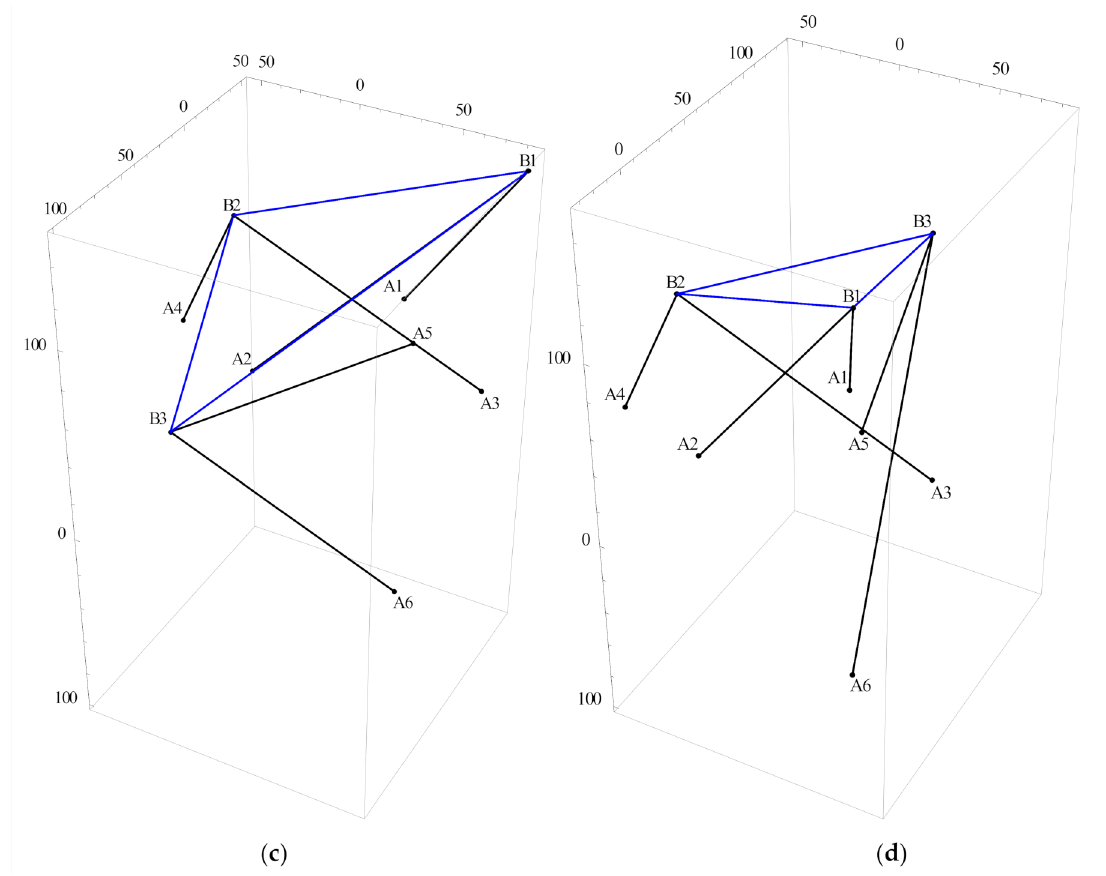
Figure 2. Four assembly configurations ( a , b , c , d ) of 6-3 Stewart platforms. Table 2. Four sets of real solutions of point B i ( i = 1,2,3 )